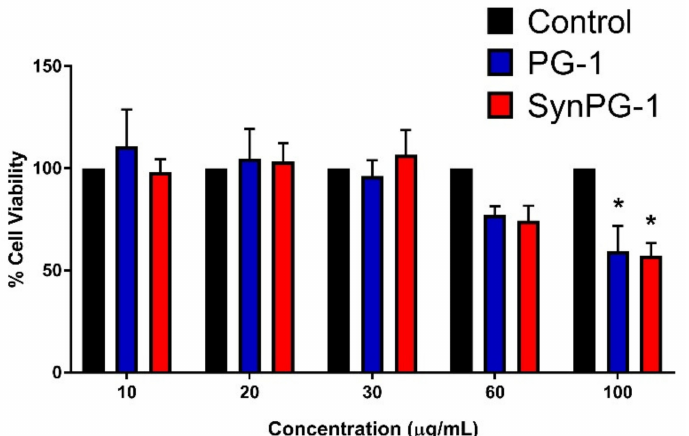
Figure 8. Comparing the cell viability of IPEC-J2 cells. Viability is represented as the % cell viability of cells in 2% serum after a 3 h incubation with peptide, relative to cells without peptide treatment. Data represents the mean ± SEM of three independent experiments, where n = 4. The asterisks represent a significant di ff erence at p < 0.05, as compared to the control by two-way ANOVA with a post hoc Tukey